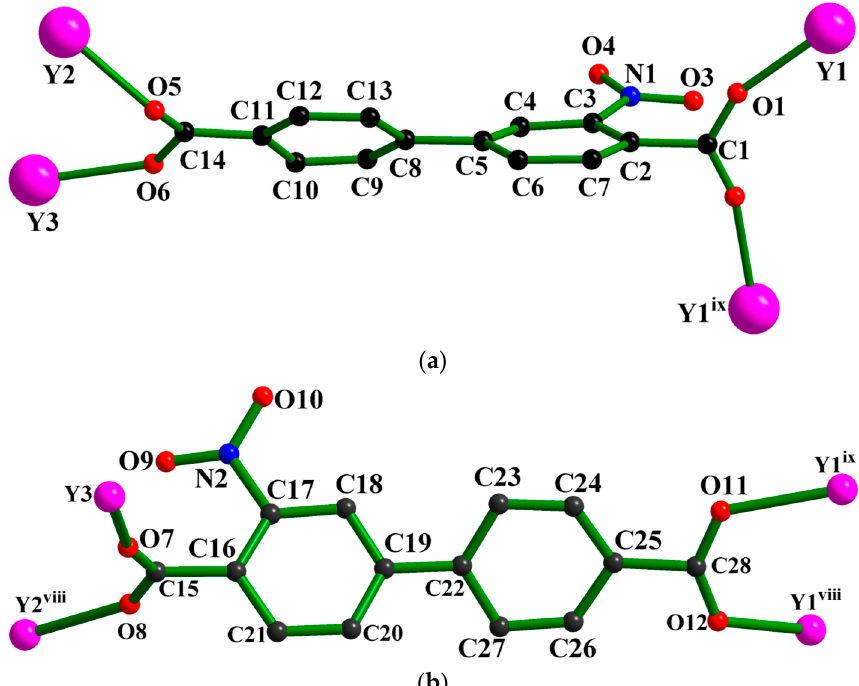
Molecules 2023 , 28 , x FOR PEER REVIEW